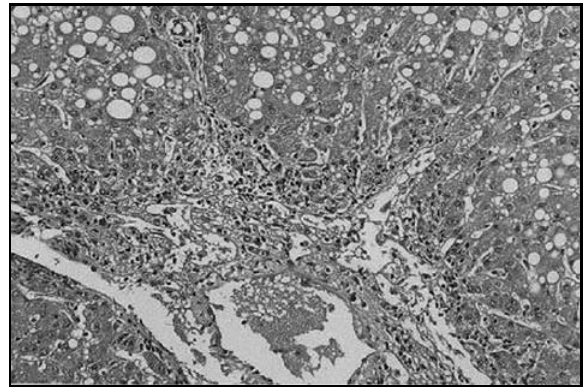
Figura 3 – Hepatócitos exibem esteatose de predominância macro-vacuolar, enquanto o tecido fibroso do espaço porta se mostra infiltrado por leucócitos mononucleares (H & E, 200X)